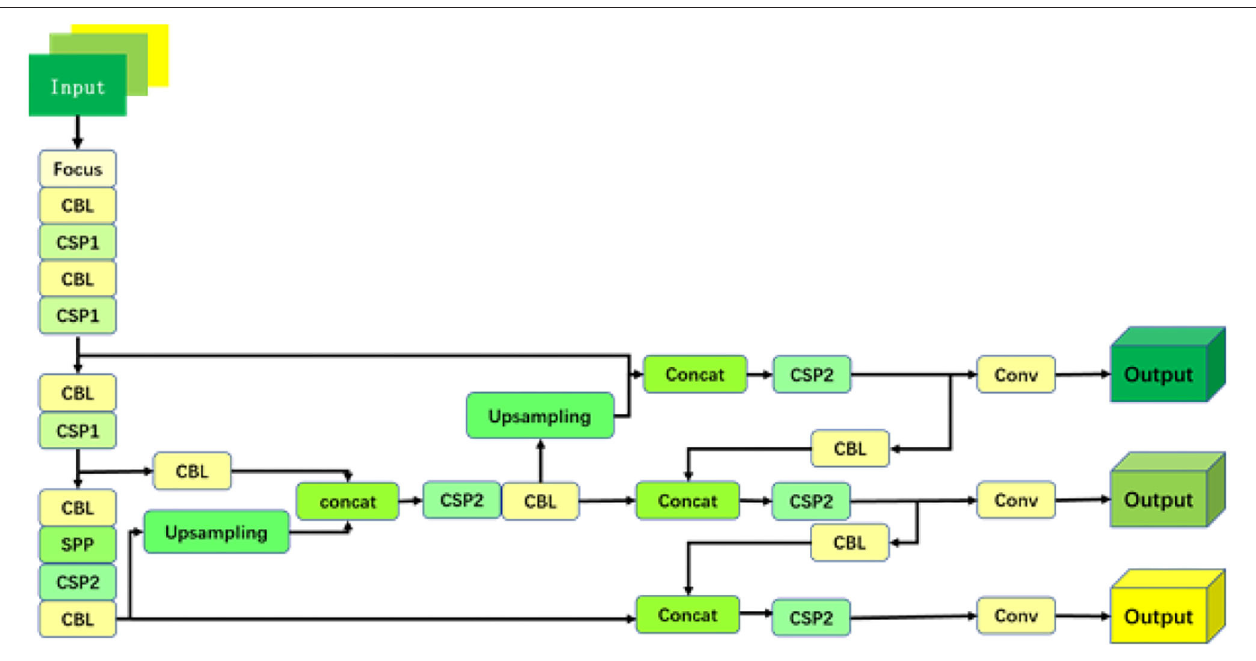
FIGURE 2 | A detection algorithm network structure